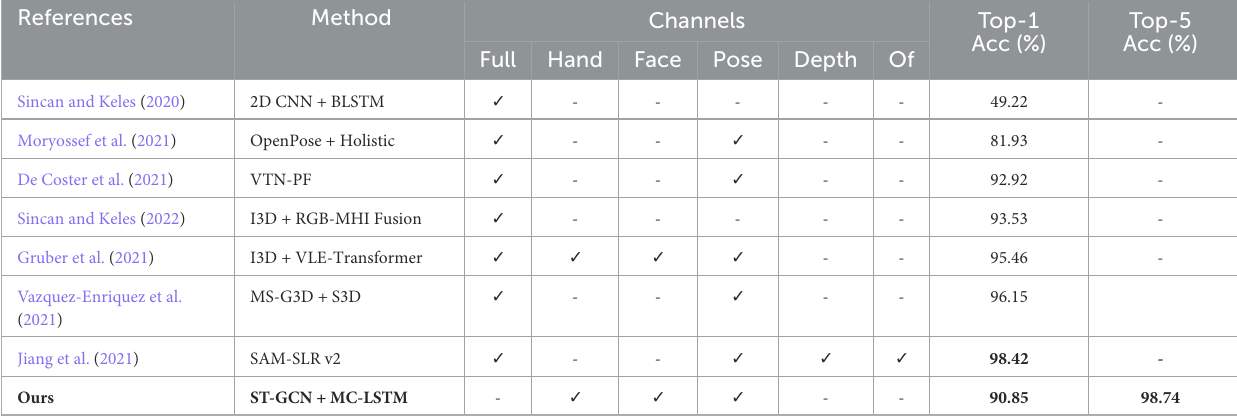
TABLE 4 Comparison with the state-of-the-art results on the test set of the AUTSL